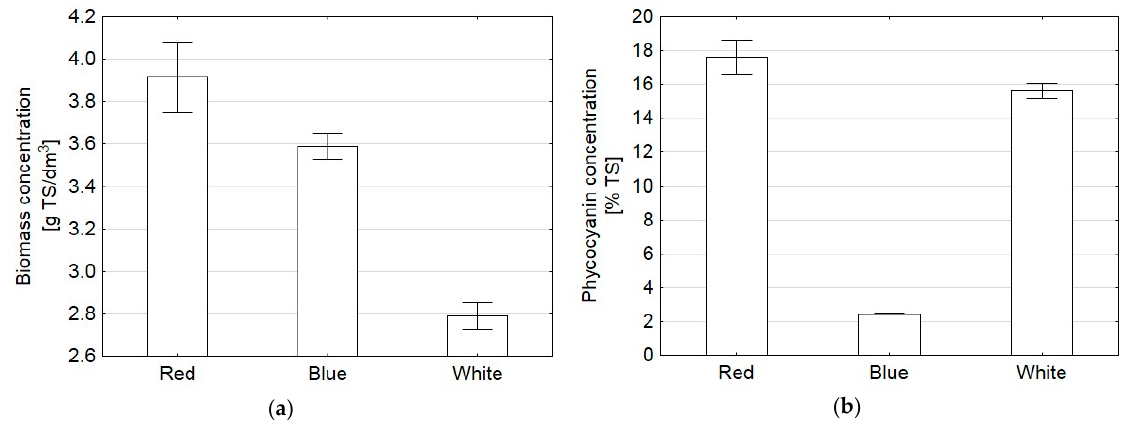
Figure 1. Effects of light wavelength on: ( a ) biomass concentration, ( b ) phycocyanin